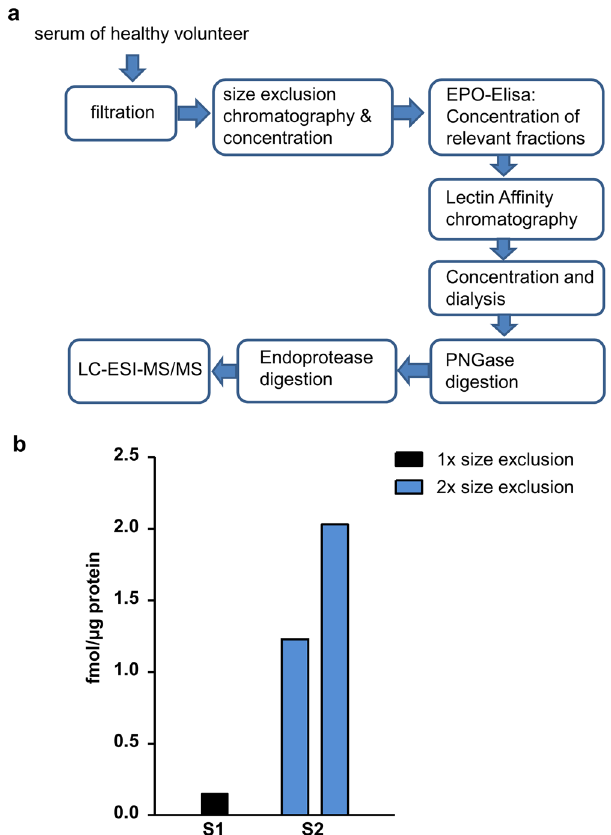
Figure 5. EV-3 protein identification in human serum from healthy donors. ( a ) Depiction of the optimized multi-step purification strategy of serum for the detection and quantification of the EV-3 specific peptide by nano-LC-ESI-MS/MS. ( b ) In serum samples of the healthy human donors (S1, S2), the EV-3 specific peptide ‘DITVGQQAVE’ was detected by using nano-LC-ESI-MS/MS. Applying two size exclusion chromatography steps to serum S2 enriched EV-3 in the sample. Compared to S1, higher levels of the EV-3 specific peptide (fmol/ µ g total protein) were quantified in two fractions of